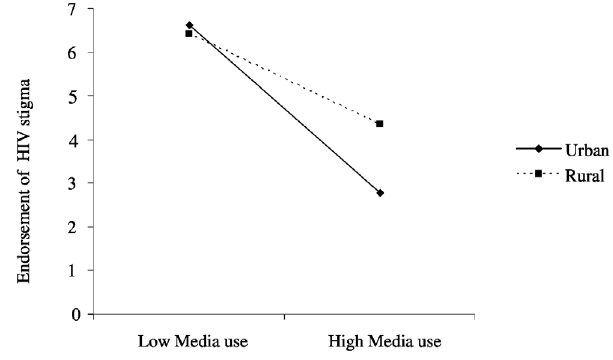
Figure 3. Regression plot for the interaction between media use and urbanity vs.